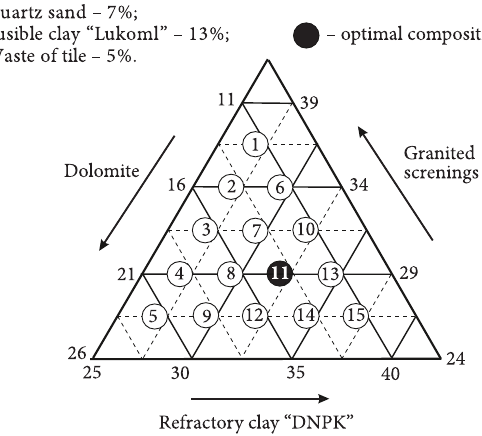
Fig. 1. The area of investigated